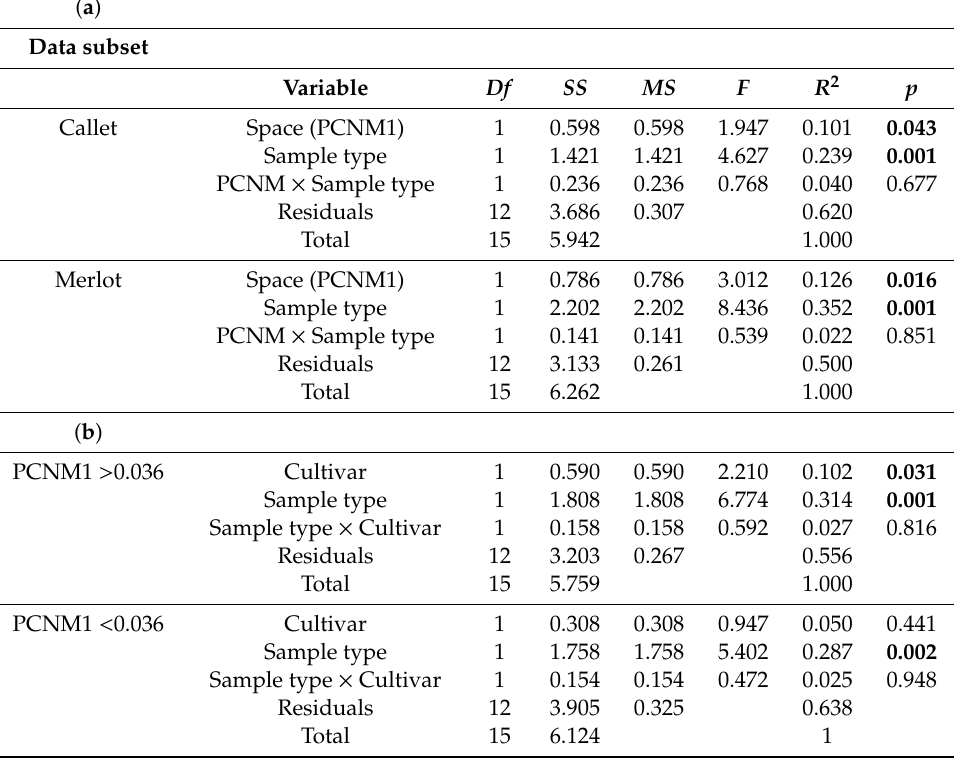
Table 3. Separate PERMANOVAs for cultivar ( a ) or PCNM1 values above and below the median value ( b ); 999 permutations and Euclidean distance as measure of dissimilarity. Bold values indicate